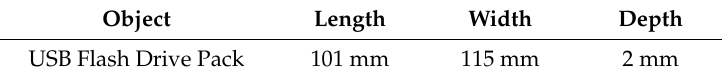
Table 7. Real dimensions of the target